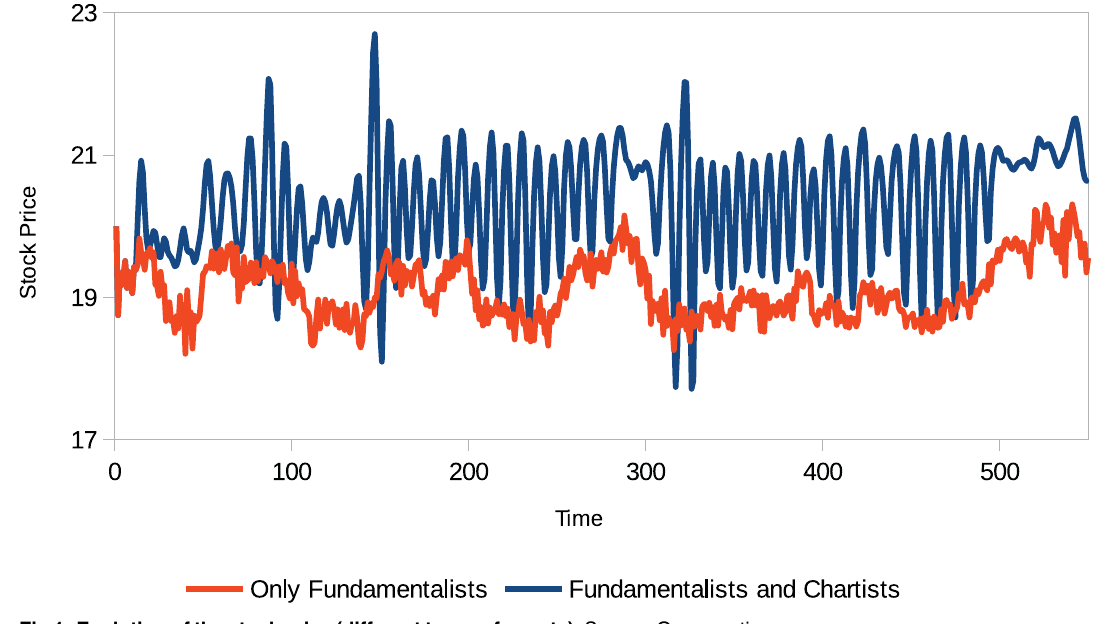
Fig 1. Evolution of the stock price (different types of agents). Source: Own